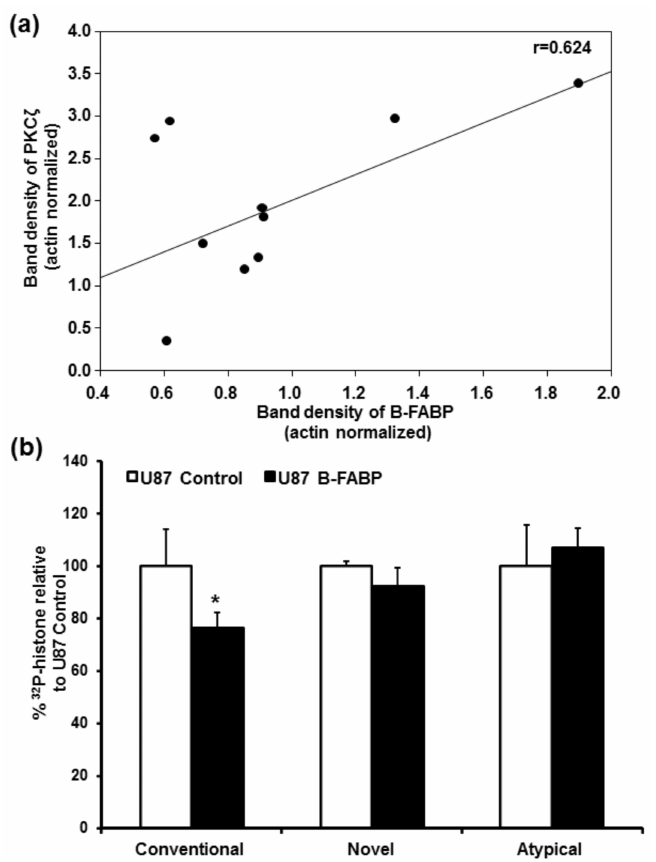
Figure 2. ( a ) Correlation between B-FABP and PKC ζ RNA levels in five B-FABP-positive GBM cell lines (U251, U373, M103, M049, and M016) and in five GBM tumor neurosphere cultures derived from different GBM patients (ED501, ED502, ED509, ED511, and ED512). PKC ζ RNA levels are indicated on the y axis and B-FABP RNA levels are indicated on the x axis. Band densities were obtained by densitometric scanning of each band using Adobe Photoshop CS4; ( b ) B-FABP is associated with reduced conventional PKC activity but has no effect on novel and atypical PKC activities. Class-specific PKC activity, calculated as percentage of 32 P-histone relative to U87 control cells, in U87 cells transfected with either empty pREP4 vector (U87 Control) or a pREP4-FABP7 expression construct (U87